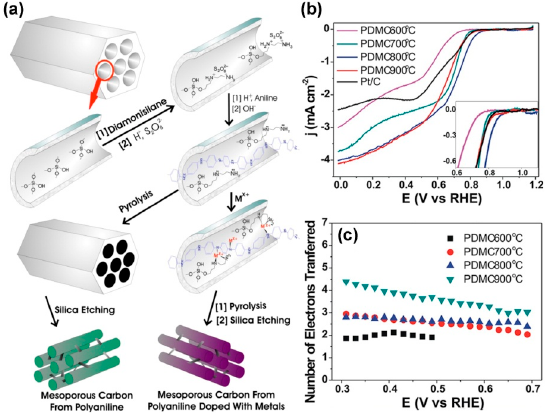
Figure 1. ( a ) Fabrication of N- and O-doped mesoporous carbons by calcination of PANI/SBA-15 and then etching SBA-15. Linear sweep voltammetry (LSV) curves at 900 rpm ( b ) and the number of electrons transferred as a function of potential for PDMCs prepared at different temperatures ( c ). Reprinted with permission from [35]. Reprinted with permission from